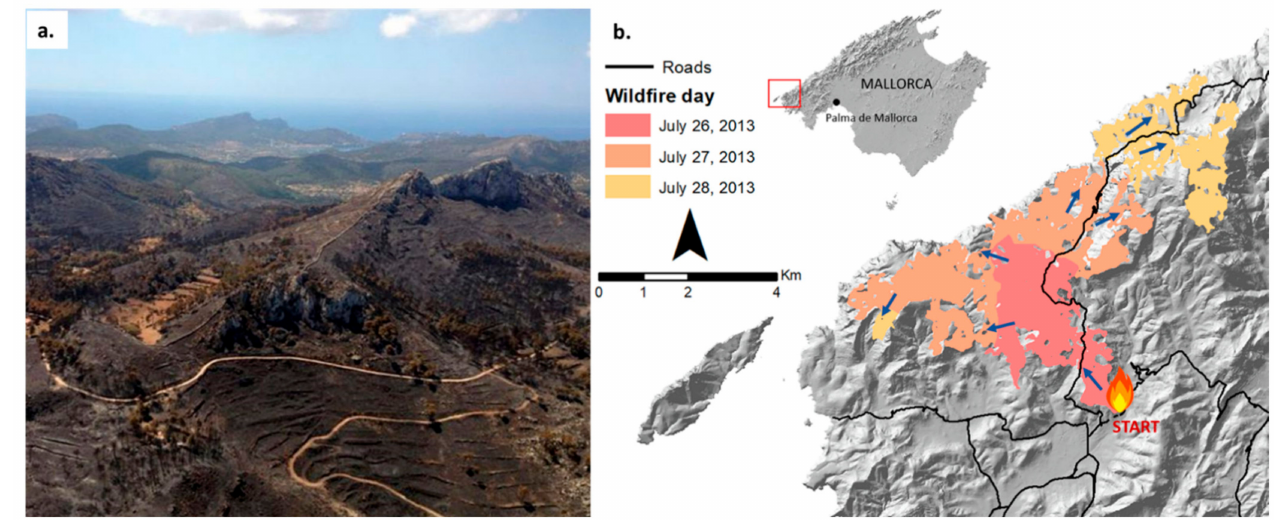
Figure 11. ( a ) The 2013 forest fire in Mallorca. A total of 2400 hectares were burned in the southwestern part of the Tramuntana range (Photo © El Pa í s). ( b ) The right map shows the spread of the fire over